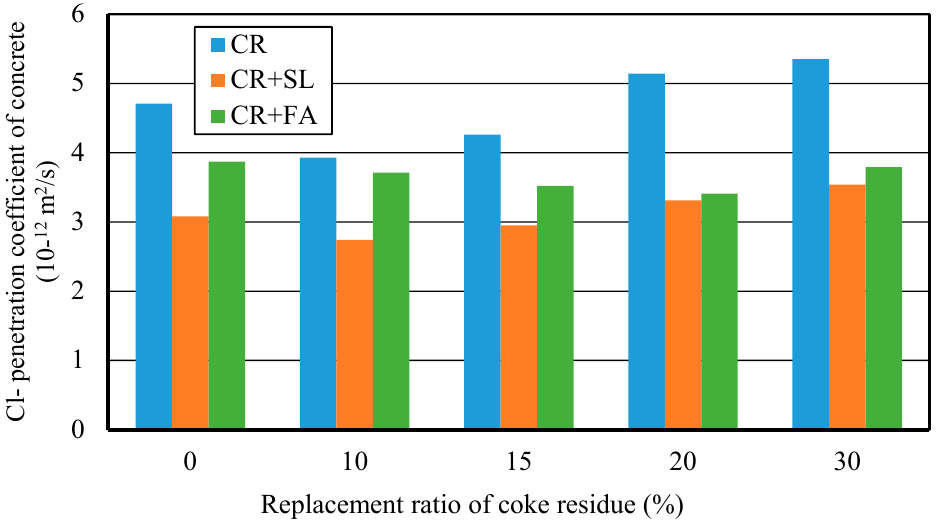
Figure 16. Cl − penetration coefficients of different kinds of concrete at 28 days.